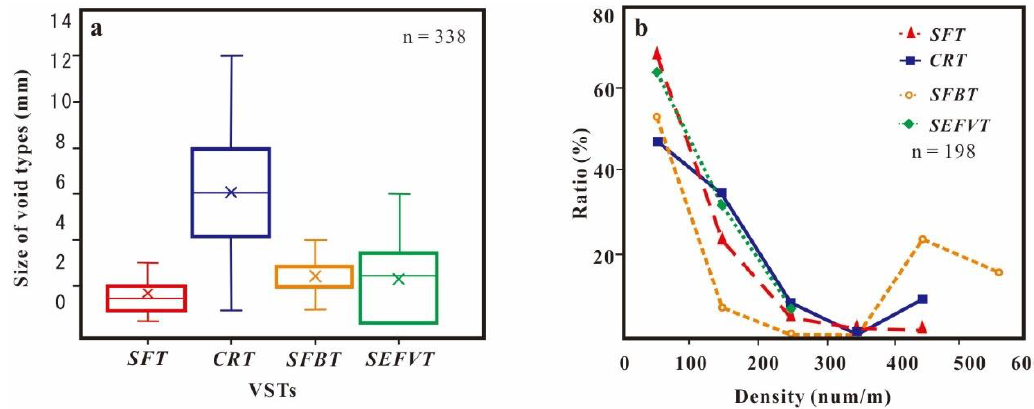
Figure 4. Characteristics of void space types (SFT:solution-filling type; CRT:cement-reducing type; SFBT:solution-filling breccia type; SEFVT:solution-enlarging fractures and vugs type) in cores: ( a ) the pore diameter; ( b ) the density observed.